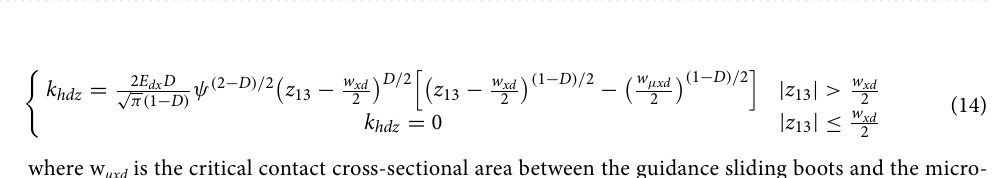
Table 2. Parameters related to hydraulic